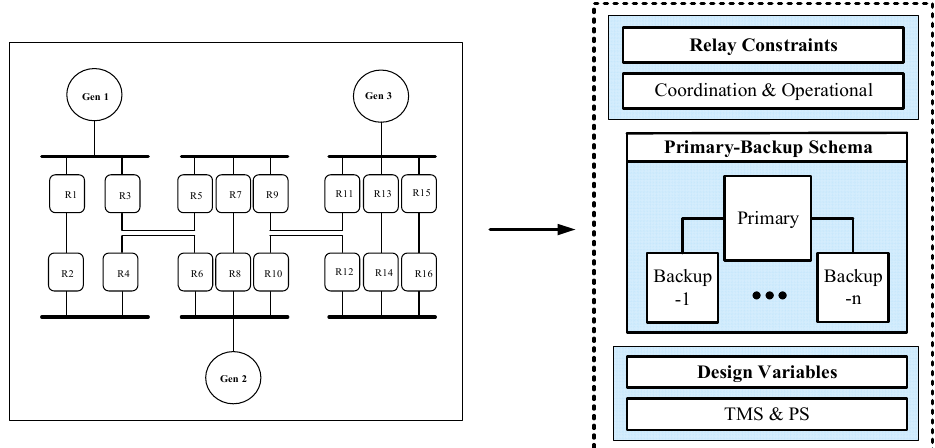
Figure 1. Outline of directional overcurrent relays (DOCR) operation for an electrical network.